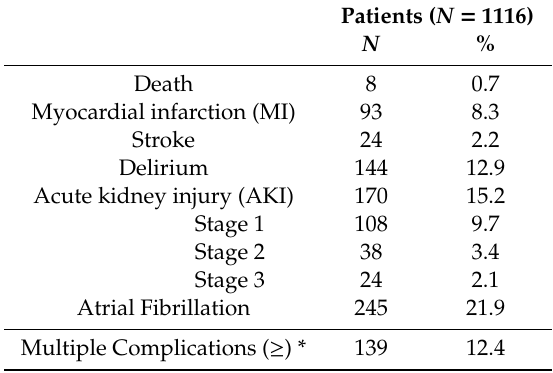
Table 3. Absolute and relative frequency of postoperative complications. * Patients a ff ected by at least two of the predefined organ dysfunctions.